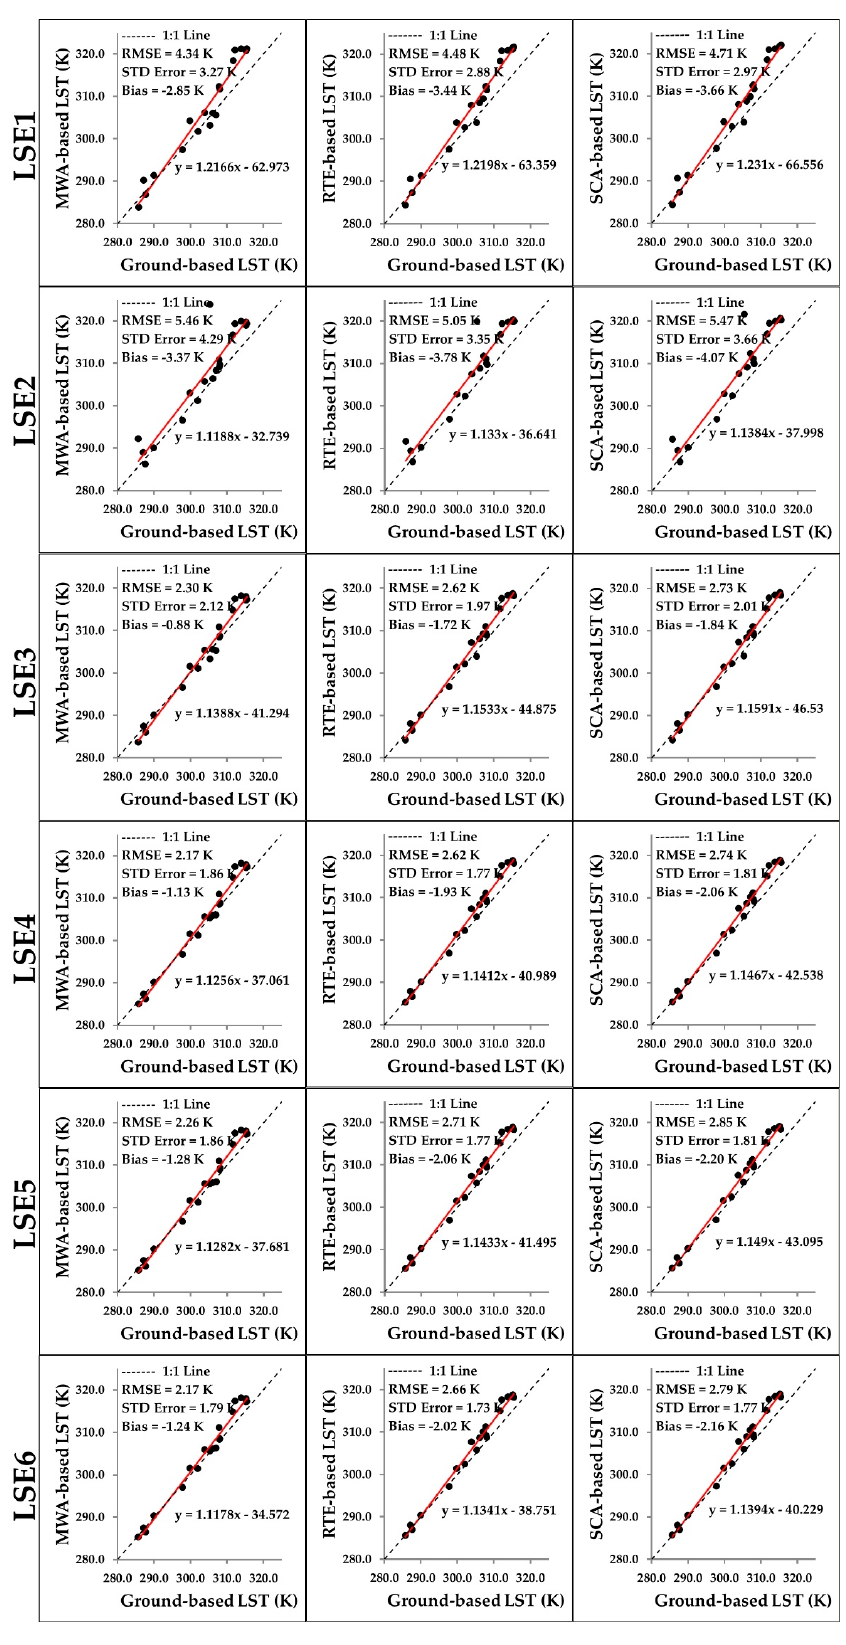
Figure 5. Daytime LST from Landsat 8, period 2013–2019 (see Appendix A): Accuracy assessment of MWA, RTE, and SCA retrieval methods with di ff erent LSE models at the nine SURFRAD and ARM